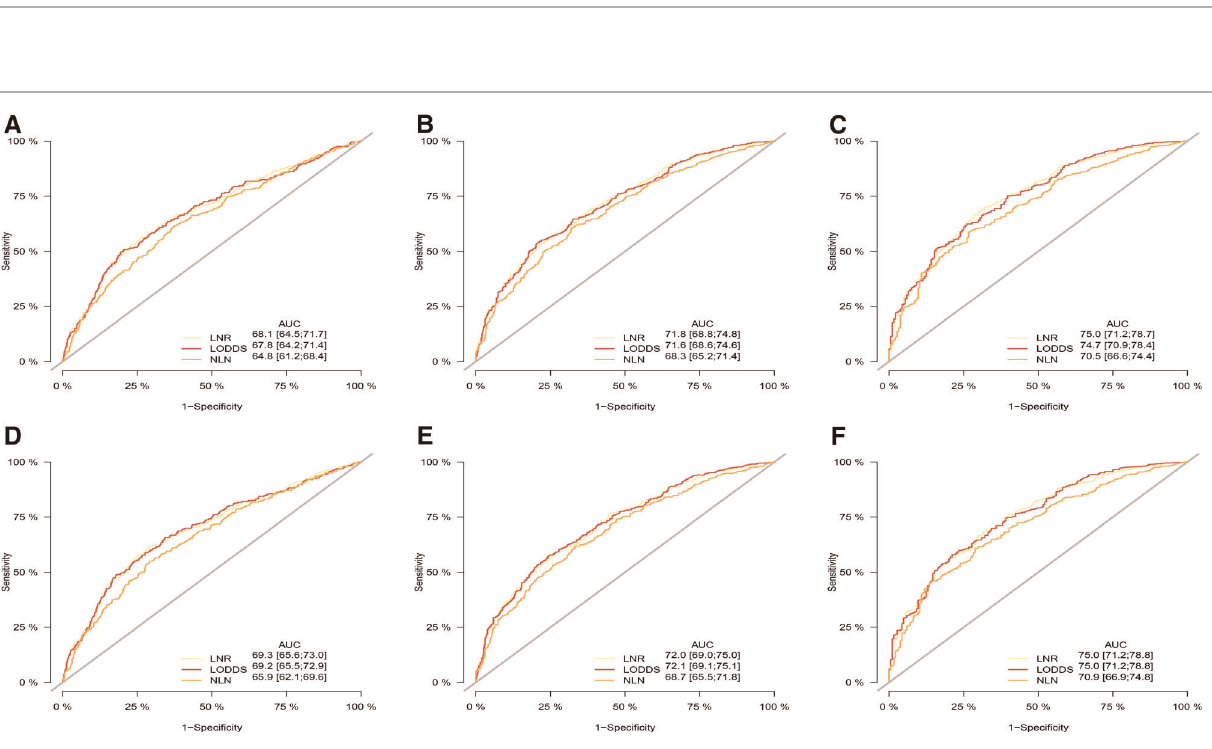
FIGURE 4 | ROC curve of the ypN stage, LNR, LODD and NLN in the prediction of prognosis of gastric adenocarcinoma patients after NAT at 1 ( A ), 3 ( B ), 5 ( C ) year point for OS and 1 ( D ), 3 ( E ), 5 ( F ) year point for CSS when LN status assessed as continuous varaible, OS, overall survival; CSS, cancer speci fi c survival; ROC, receiver operative curve; LNR, lymph node ratio; LODDS, log odds of positive lymph node; NLN, negative lymph